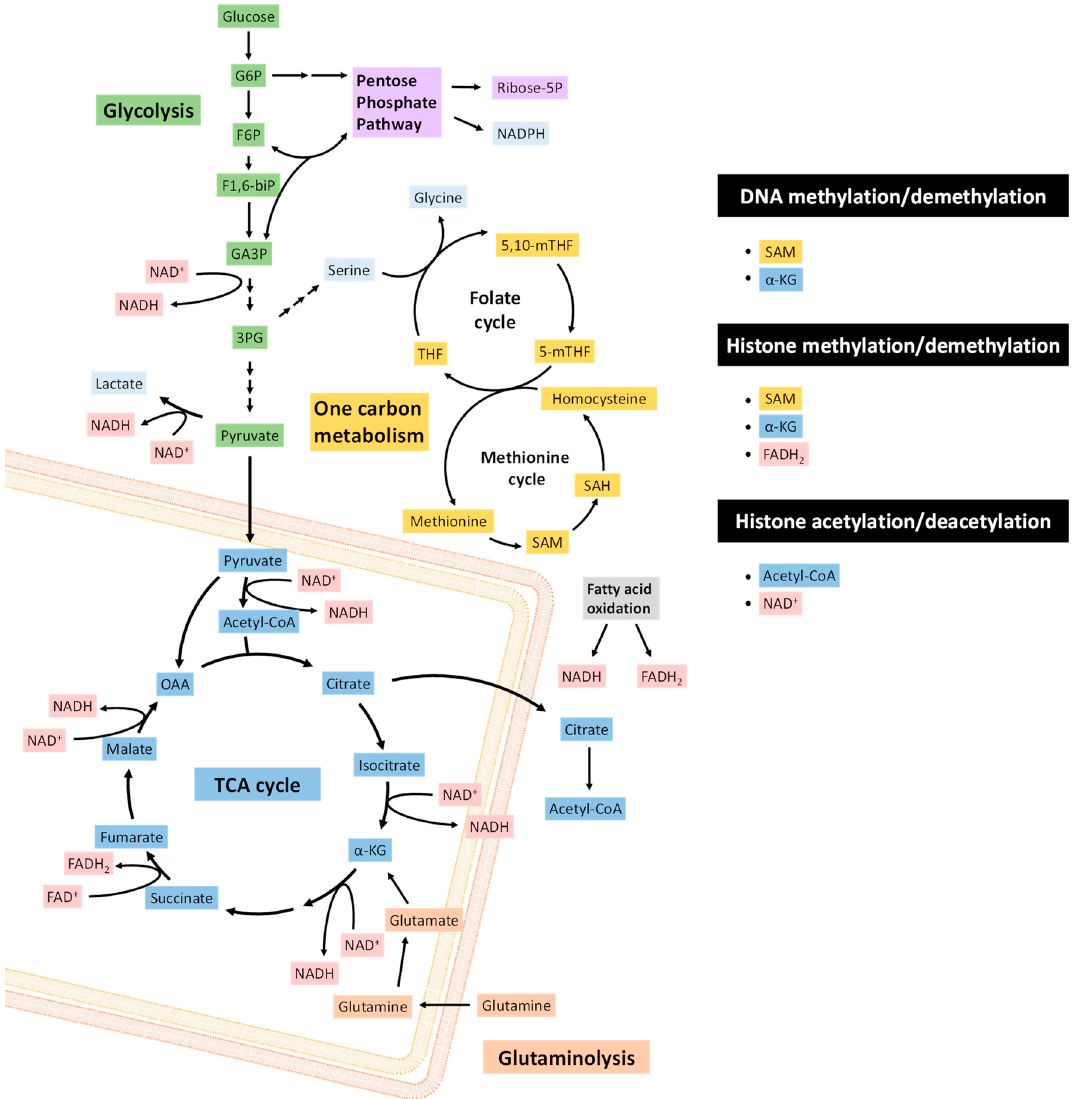
Figure 1. Metabolic requirements of protein and DNA methylation and protein acetylation. S-adenosyl-methionine (SAM) acts as a methyl donor for histone and DNA methylation. SAM is produced through one-carbon metabolism. Demethylation can require the tricarboxylic acid (TCA) cycle intermediate α -KG as a co-factor, and can be inhibited by other TCA cycle products: Succinate, fumarate or 2-hydroxyglutarate (2-HG). Histone demethylation by lysine-specific histone deacetylase 1 (LSD1) can also require the flavin adenine dinucleotide reduced form (FADH2), whose pools are dependent upon fatty acid oxidation and the TCA cycle. Histone acetylation requires acetyl-CoA, obtained from citrate or fatty acid oxidation in the TCA cycle. Histone deacetylation by sirtuin (SIRT) histone deacetylases is NAD + -dependent. NADH pools derive from multiple metabolic pathways, including glycolysis, pyruvate oxidation by pyruvate dehydrogenase (PDH), the TCA cycle, fatty acid oxidation, amino acid oxidation and OXPHOS. The metabolites involved in di ff erent pathways are shaded in di ff erent colors: Glycolysis (green), one carbon metabolism (yellow), pentose phosphate pathway (purple), TCA cycle (blue), NADH and FADH2 (pink) and glutaminolysis (orange).